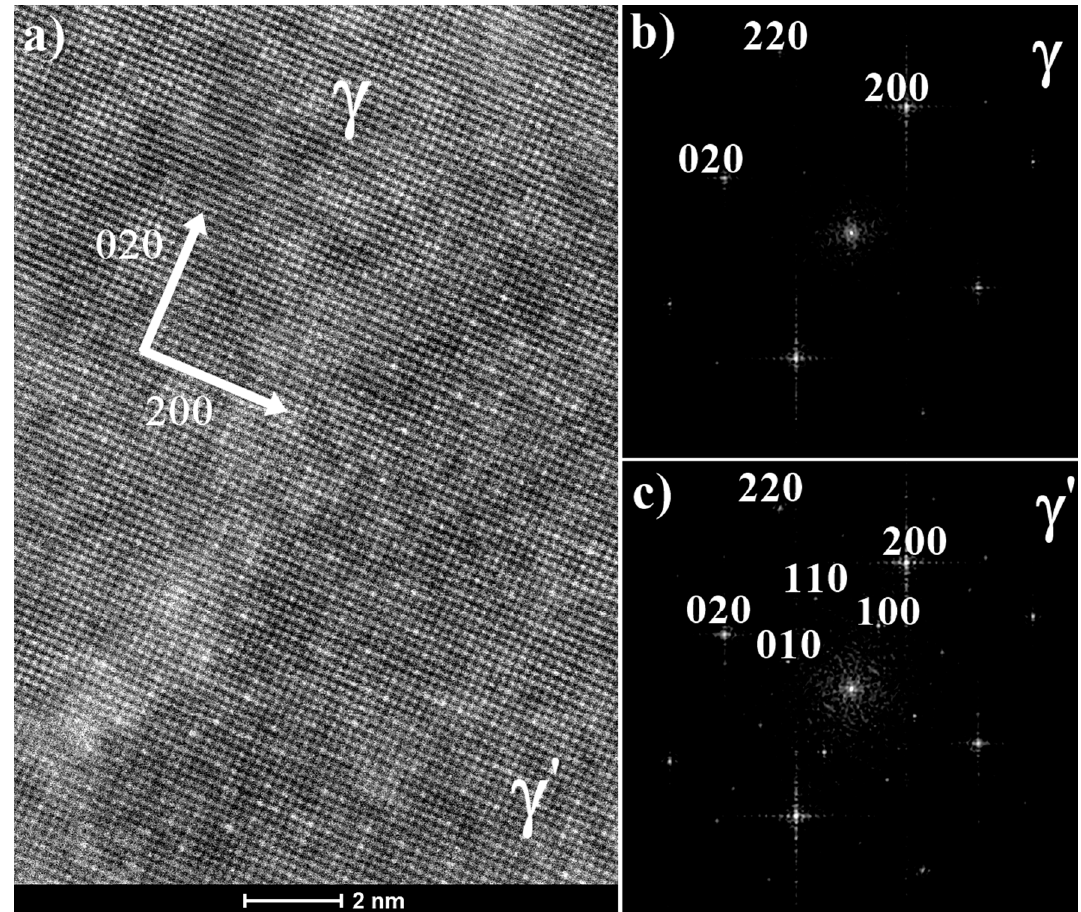
Figure 5. Interface γ / γ ': ( a ) γ and γ ' phases structure in atomic scale resolution, zone axis [001]; ( b ), ( c ) diffraction peaks of γ and γ ' calculated by fast Fourier transformation (FFT).